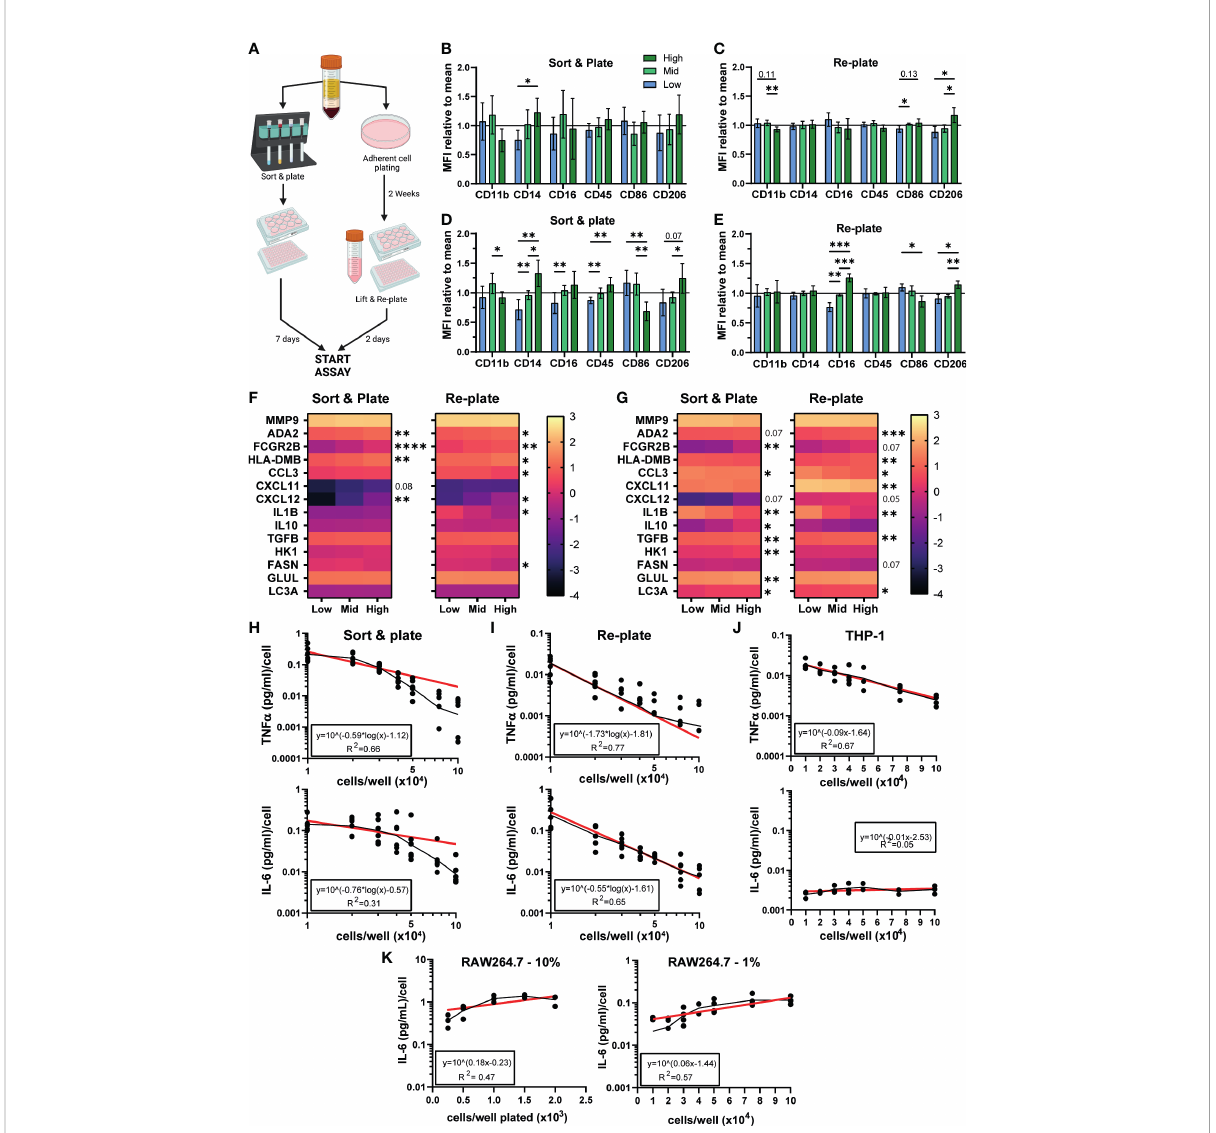
FIGURE 6 Density dependent differences in phenotype are observable in MDMs, THP-1, and iPSC-derived microglia. (A) Schematic of MDM isolation and plating strategies. Created with BioRender.com. (B – E) MDM surface marker phenotype is in fl uenced by density. (B, C) MFI normalized to the mean of all 3 densities of macrophage markers on unstimulated MDM cultured via (left) sorting and plating the cells, or (right) replating after 2 weeks differentiation. (D, E) MFI normalized to the group mean of LPS/IFN g polarized MDM. (B – E) “ Sort & plate ” n=8 independent donors, “ Re- plate ” n=7, Two-way ANOVA with Tukey ’ s multiple comparisons test and Greenhouse-Geisser correction. (F, G) qPCR for genes differentially expressed in iPSC-Macs at different densities in (F) unstimulated or (G) LPS/IFN g polarized MDM. Scale represents Log 10 (2 - D Ct ) and signi fi cance is indicated for low vs high comparison. (F) n=6 each for “ Sort & plate ” and “ Re-plate ” , (G) n=6 “ Sort & plate ” , n=5 “ Re-plate ” . (F, G) Two-way ANOVA, Tukey ’ s multiple comparisons test with Greenhouse-Geisser correction. (H – K) Density effect on cytokine secretion by MDM and immortalized cell lines. (H-J) Secretion of (top) TNF a or (bottom) IL-6, by (H) “ Sort & plate ” MDM, (I) “ Re-plate ” MDM, or (J) PMA-differentiated THP-1 macrophages after stimulation with 1 µg/mL Pam3CSK4. Secretion is normalized to number of cells plated. Geometric mean (black line) and Non-linear curve fi t lit (red) are displayed. (H, I) “ Re-plate ” TNF a n=8, All other MDM n=6. (J) TNF a n=4, IL-6 n=3. (K) Murine RAW264.7 cultured in standard serum (10%, left, n=3) or reduced serum (1%, right, n=4) conditions, IL-6 secretion post stimulation with Pam3CSK4. Signi fi cance is de fi ned as * <0.05, ** <0.01, ***<0.001,